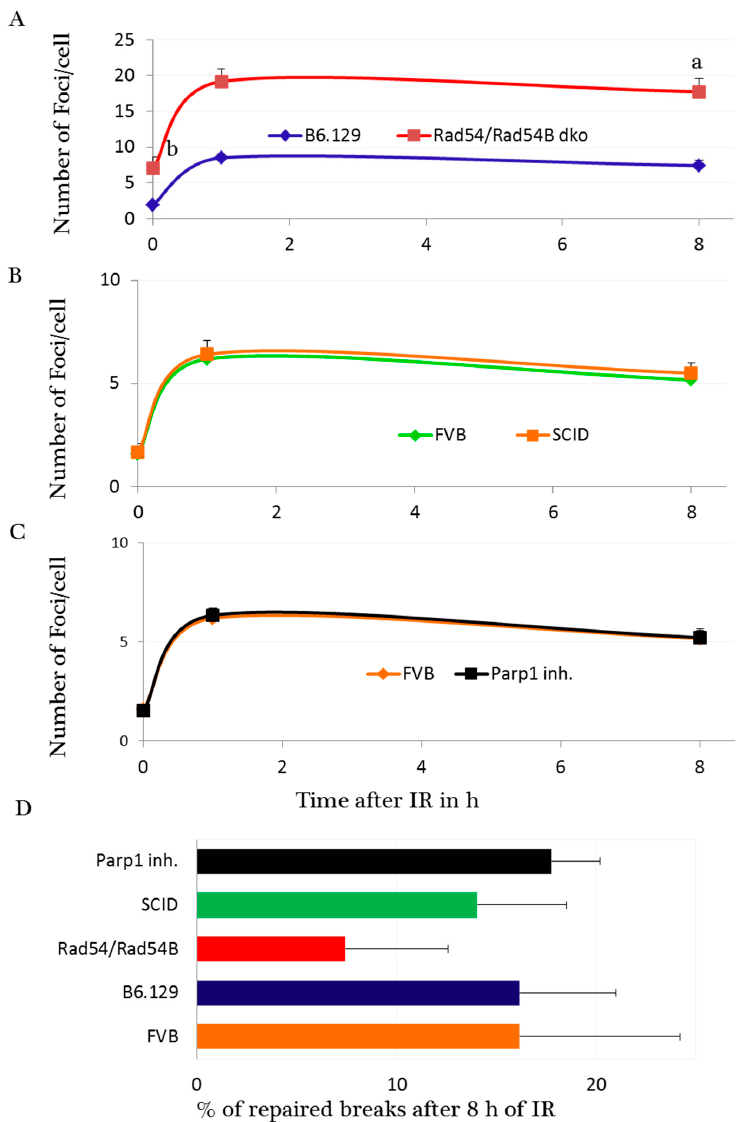
Figure 4. The kinetics of γ -H2AX foci formation and removal after IR in elongated spermatids. Number of γ -H2AX foci per cell in RAD54/RAD54B double knockout mice ( A ), SCID mice ( B ) and PARP1 inhibitor (DPQ)-treated mice ( C ) relative to the wild type mice. Between 40 and 50 cells were counted per mouse, data are presented as mean ± SEM, n = 3. p < 0.01, a compared to 8 h irradiated B6.129, b compared to the elongated spermatids in all non-irradiated mice. Percentages of repaired breaks after 8 h post- IR in wild type and other mice ( D ).